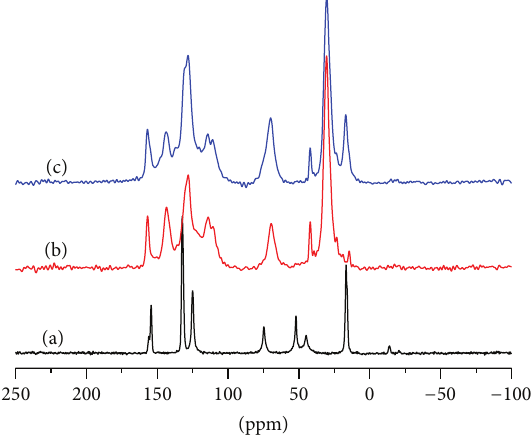
Figure 5: 13 C CP/MAS NMR spectra of samples ((a) TMBPDE; (b) UFUR; (c) TMBPDE-15